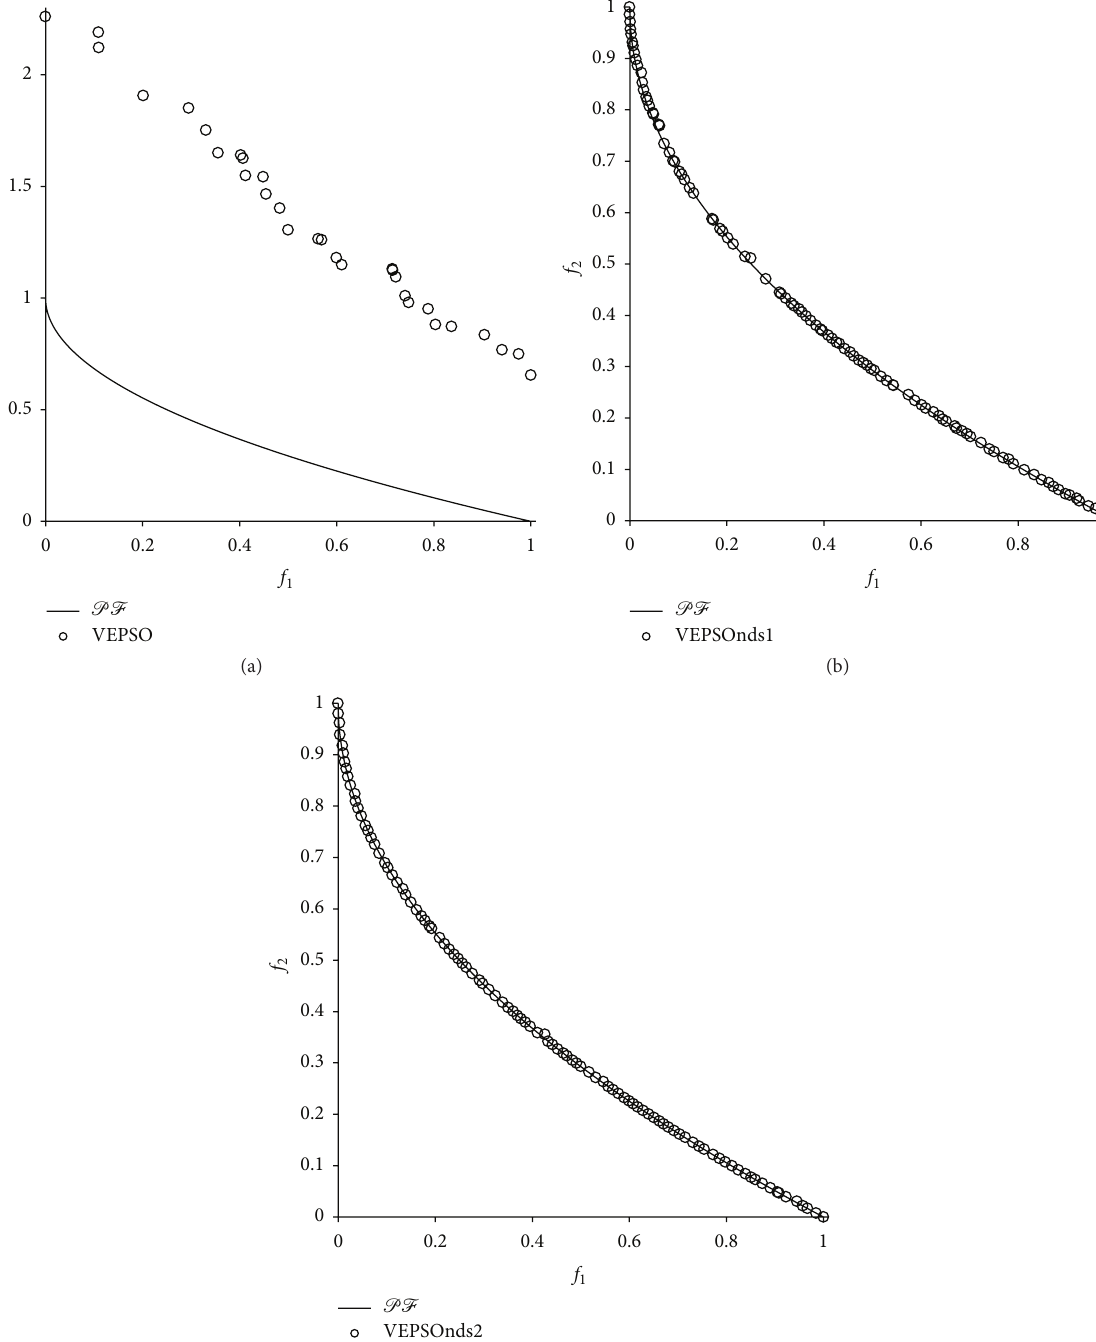
VEPSOnds1 and VEPSOnds2 algorithms generated